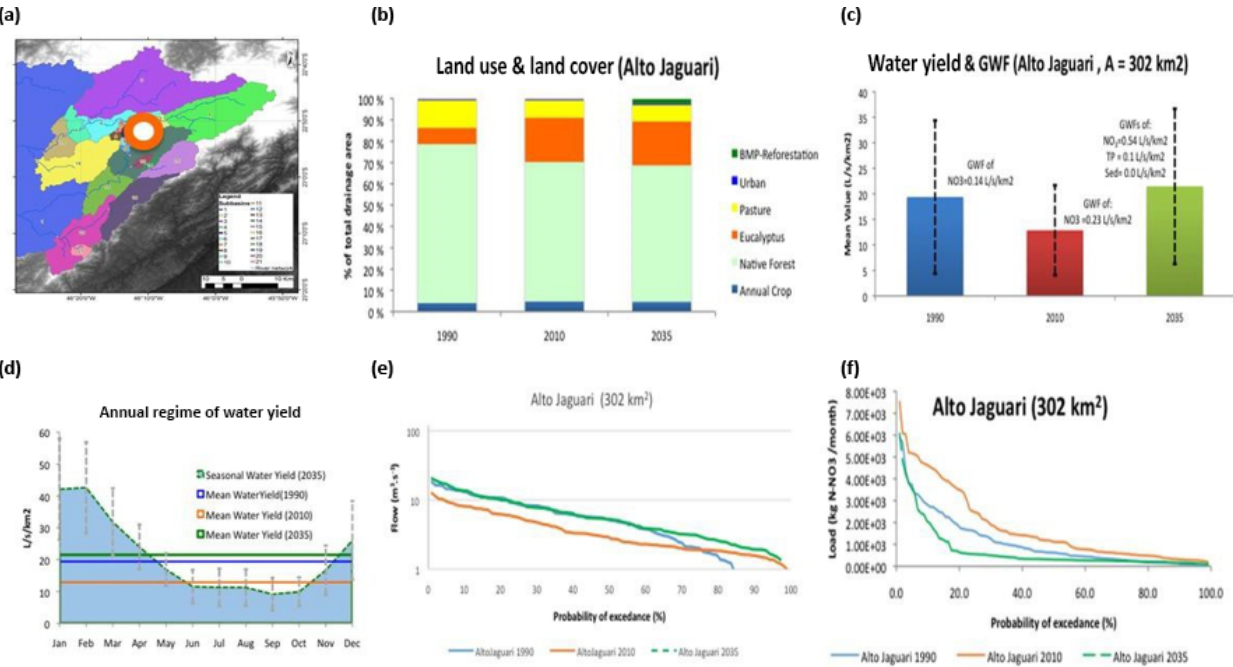
Figure 13. Synthesis chart of case study of the Upper Jaguari sub-basin (drainage area = 302km 2 ). (a) Localization at the drainage areas of the Cantareira system; (b) LULC conditions for scenarios S1 (1990), S2 (2010) and S2 + EbA (2035); (c) comparison of water yields simulated for conditions of S1, S2 and S2 + EbA; (d) water yield scenarios compared with intra-annual regime of S2 + EbA scenario; (e) comparison of duration curves of flows for S1, S2 and S2 + EbA conditions; (f) duration curves of N-NO3 loads for S1, S2 and S2 + EbA.